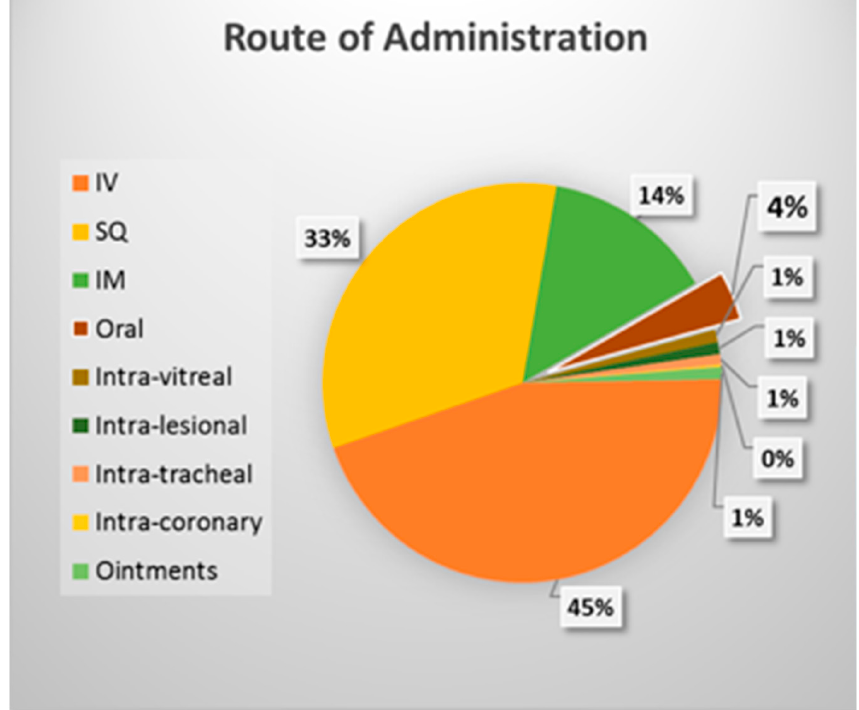
Figure 1. Pie charts display the current distribution of FDA-approved peptide drugs based on their route of administration [7].